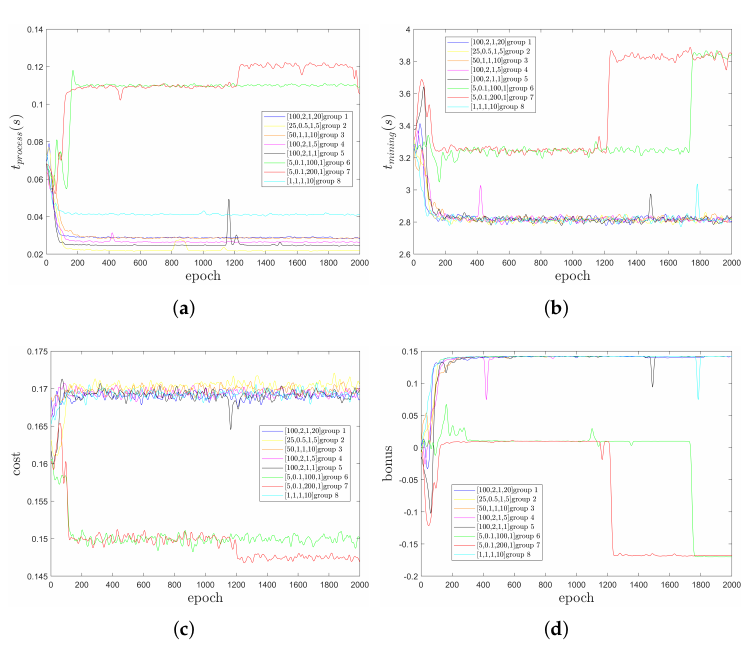
Figure 6. The convergence of reinforcement learning; ( a ) Average process delay per epoch; ( b ) average mining delay per epoch; ( c ) average cost per epoch; ( d ) average bonus per